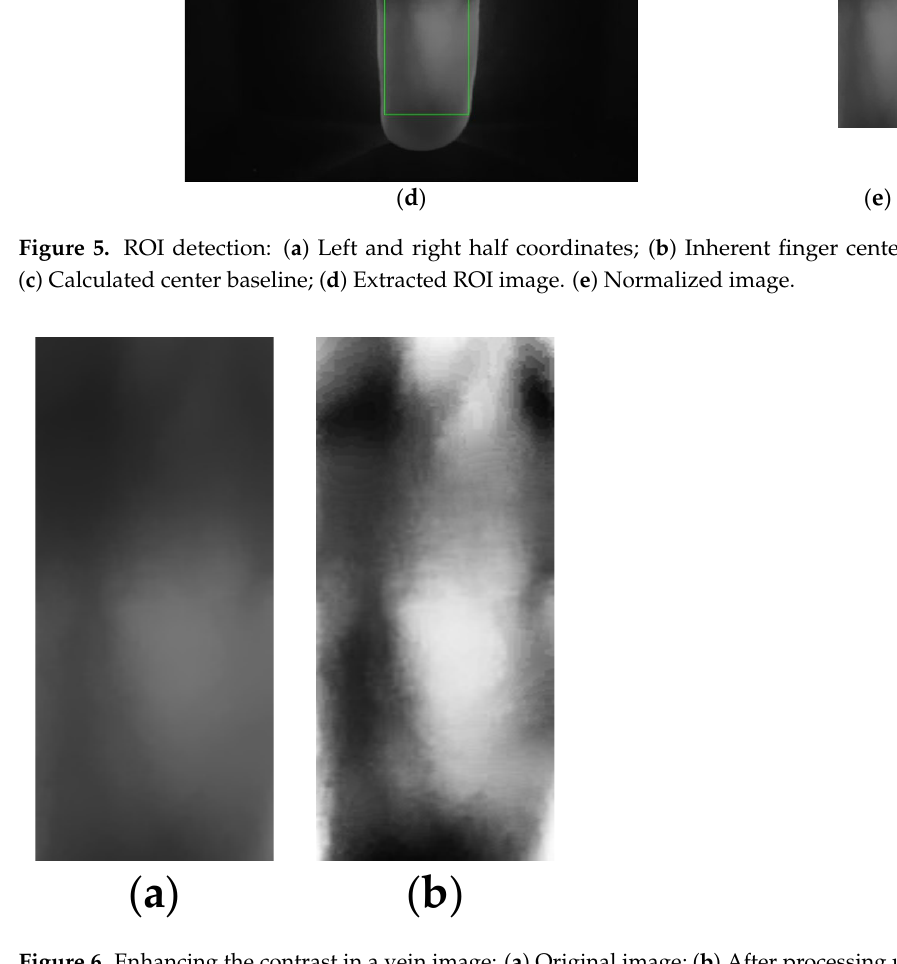
Figure 6. Enhancing the contrast in a vein image: ( a ) Original image; ( b ) After processing using POE.